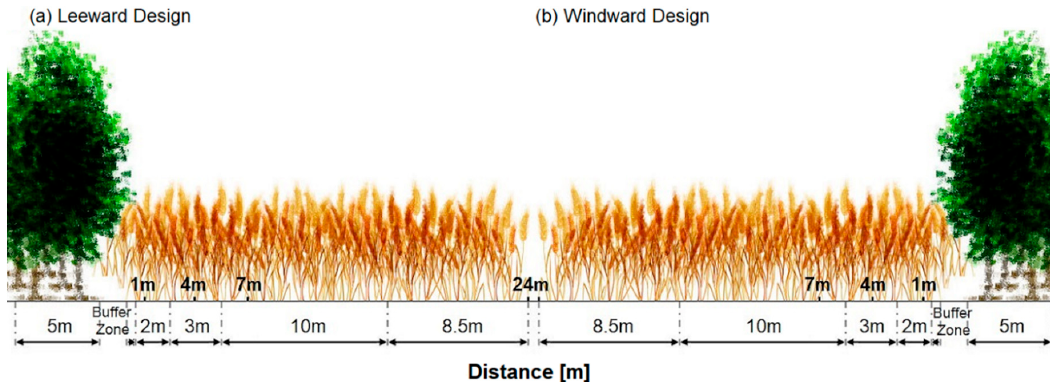
Figure 1. To-scale design of the leeward ( a ) and windward ( b ) alley-cropping-plots, together with the harvest points set at 1 m, 4 m, 7 m, and 24 m away from the tree strips. The supplemented distances (i.e., 2 m, 3 m, 10 m, and 8.5 m) sum up half of the neighbouring distances of the harvest points and represent the weights used for calculating the overall crop yield. The buffer zone represents a distance of 1.5 m between the tree strip and crop alleys.